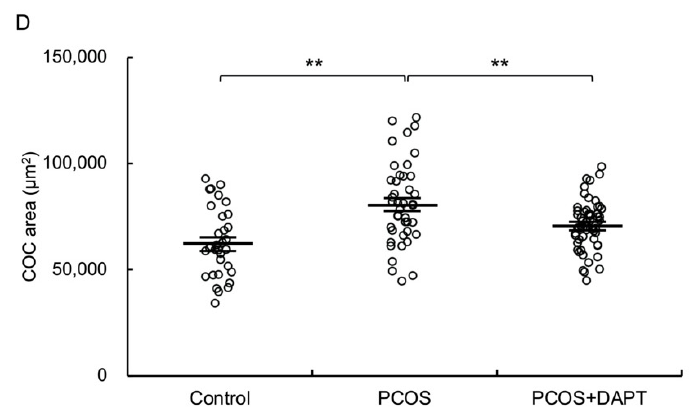
Figure 7. Notch signaling mediates COC expansion in PCOS model mice. Mice were injected subcutaneously with DHEA (60 mg/kg body weight) (PCOS, n = 4 or PCOS + DAPT, n = 4) or sesame oil (control, n = 4) daily for 20 days. Mice were injected intraperitoneally with 10 IU PMSG followed 48 h later with 10 IU hCG. After PMSG injection, mice were injected intraperitoneally with DAPT (25 mg/kg) (PCOS + DAPT) or DMSO (control or PCOS) every 24 h. Mice were euthanized at 14 h after hCG injection. COCs were isolated from oviducts. ( A – C ) Representative microscopic images of COCs harvested from each group of mice: ( A ) control, ( B ) PCOS, and ( C ) PCOS treated with DAPT. The scale bars indicate 200 µm. ( D ) Quantitative analysis of the areas of COCs. Values represent means ± SEM. ** p < 0.01.